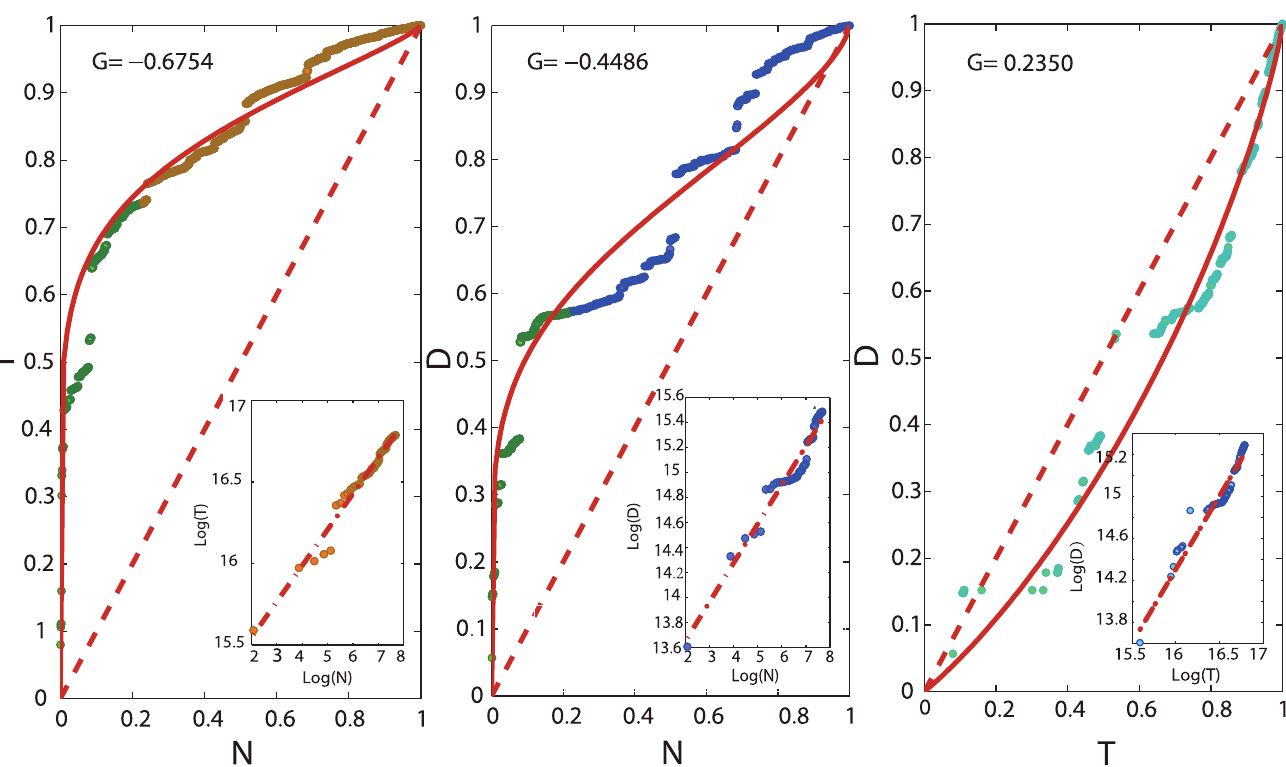
Fig 6. The Lorenze-liked curves and the GINI-liked coefficients among cumulative attention flows, attention dissipations, and the number of websites along the radius. The green nodes in the two sub-figures on the left mean the attention flows or dissipations of the 20% websites in the core. The insets show the log-log plots of the focal variable